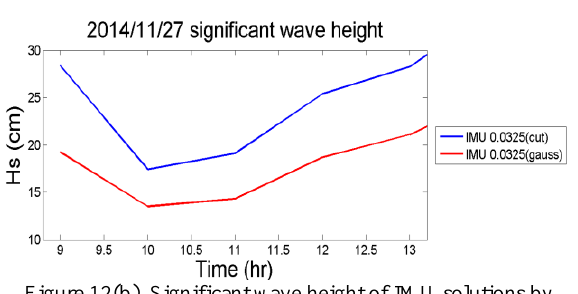
Figure 12(b). Significant wave height of IMU solutions by High-pass filter and Gaussian filter.